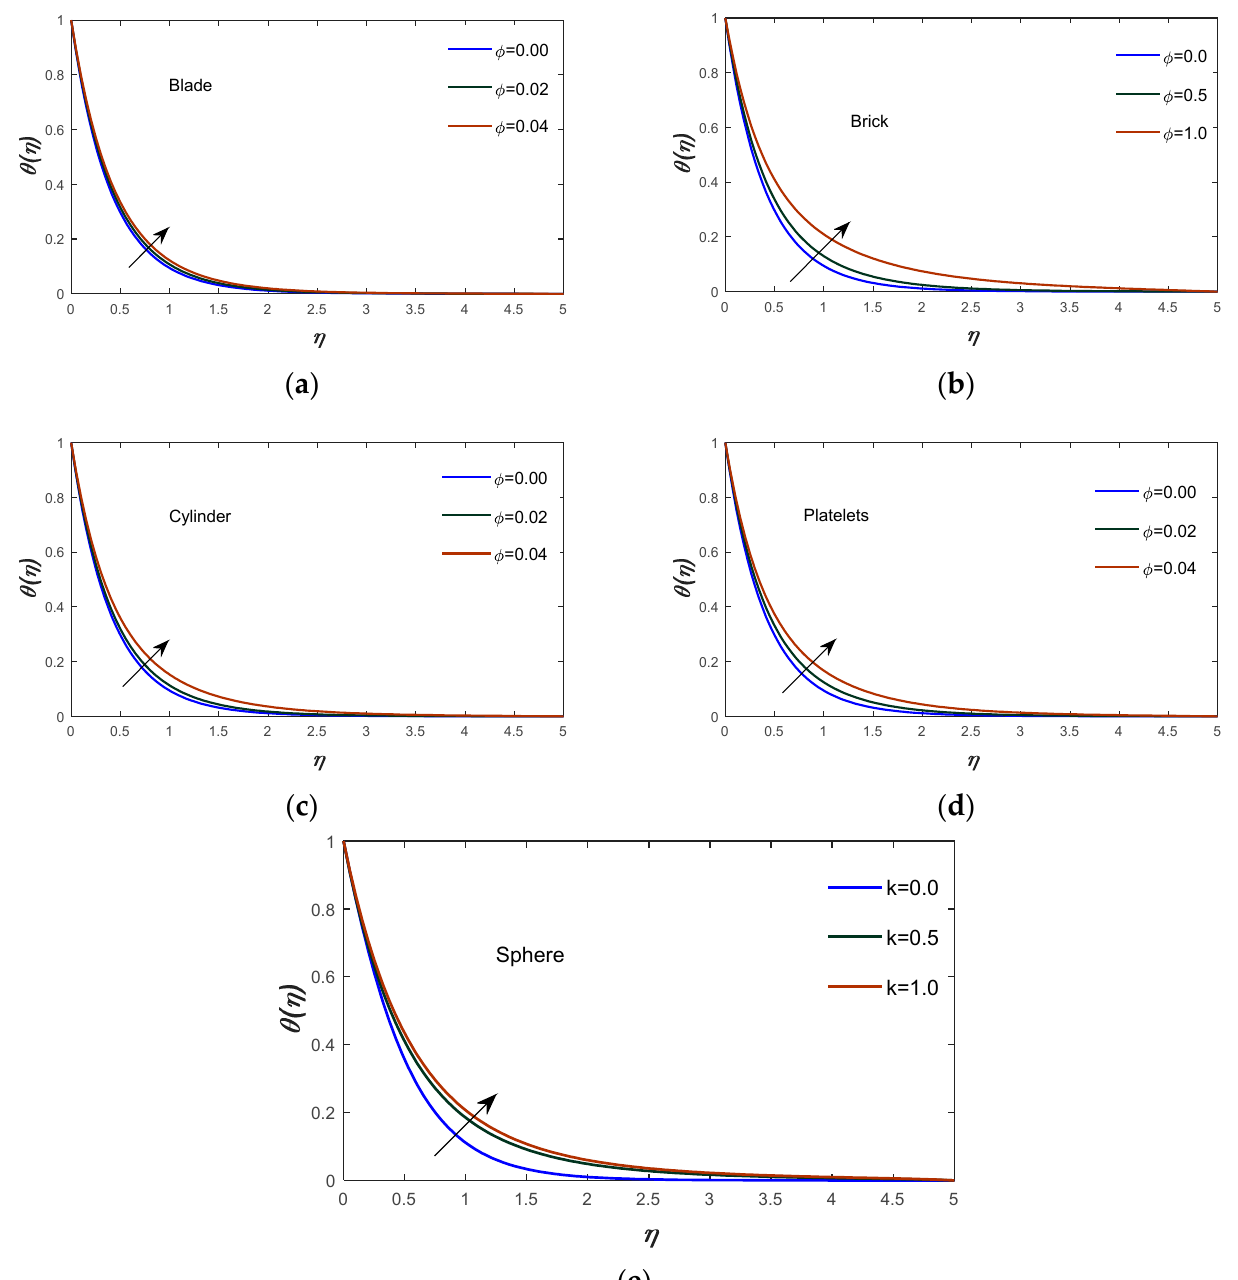
Figure 8. ( a – e ). Impact of 𝐾 on 𝜃(𝜂) by using various shapes factors of nanoparticles 𝑀 = 1.0, 𝑃𝑟 = 6.0, 𝑆 = 0.5, 𝐸𝑐 = 1.0, 𝑘 = 0.5 .